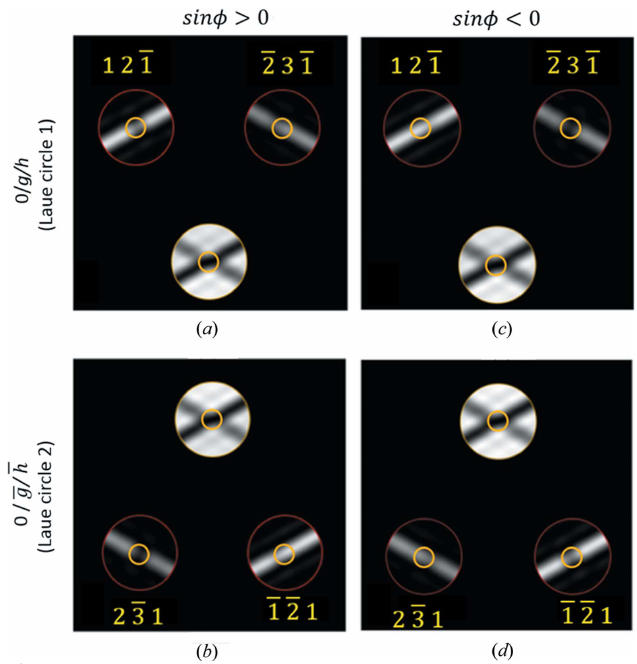
Figure 3 An illustration of Criterion 3 using simulated CBED patterns of alpha- quartz near [ (cid:3) 11 (cid:3) 33 (cid:3) 77]. Two different types of alpha-quartz which belong to different space groups are used: the structure in ( a ) and ( b ) is in the space group P 3 2 21, the structure in ( c ) and ( d ) is in the space group P 3 1 21. The two structures are enantiomorphs of each other. The yellow circles enclose the three-beam conditions and their neighourhoods. For the structure in ( a ) and ( b ), (cid:2) ¼ ’ structure in ( c ) and ( d ), (cid:2) ¼ ’